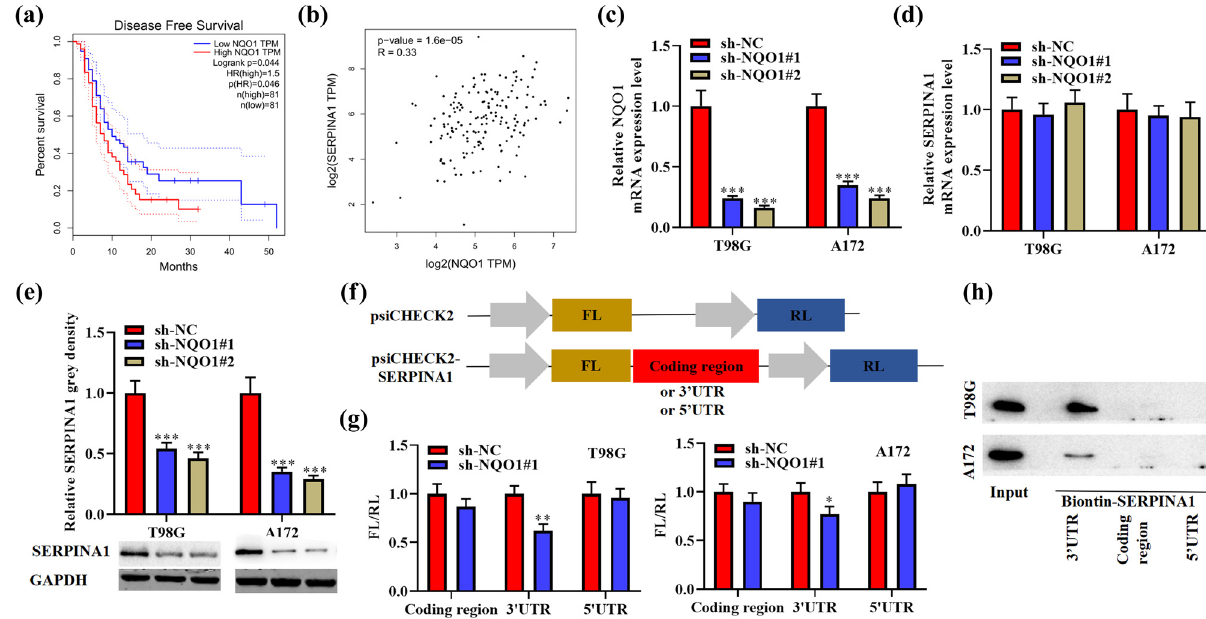
Figure 3: NQO1 enhanced SERPINA1 mRNA translation through binding to the 3 ′ UTR. ( a ) Kaplan – Meier survival curves of disease - free survival of patients who had gliomas with di ff erential expression of NQO1 . ( b ) Correlation between NQO1 and SERPINA1 expression in glioma tissues. ( c ) Relative NQO1 mRNA expression level in T98G and A172 cells transfected with sh - NQO1, determined by qRT - PCR assay. One - way ANOVA was conducted. ( d ) Relative SERPINA1 mRNA expression level in T98G and A172 cells transfected with sh - NQO1, determined by qRT - PCR assay. One - way ANOVA was conducted. ( e ) Relative SERPINA1 grey densities in A172 and T98G cells after transfection with sh - NQO1. One - way ANOVA was conducted. ( f ) 3 ′ UTR, coding region, and 5 ′ UTR of SERPINA1 mRNA were subcloned downstream FL coding sequence, with RL expressed from the same construct as control. ( g ) The ratios of FL/RL activity in glioma cells. NQO1 silencing inhibited FL/RL reporter activity in T98G and A172 cells. Student ’ s t test was conducted. ( h ) RNA pull - down assay followed by western blot revealed the existence of NQO1 protein that is pulled down by biotin - labelled SERPINA1 3 ′ UTR. Data are expressed as means ± SEM ( * p < 0.05; ** p < 0.01; *** p < 0.001, n = 3 )